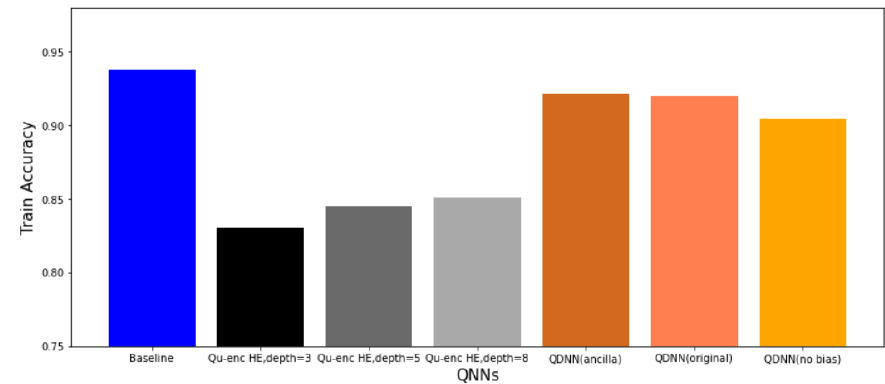
Figure 8. Accuracy values of different QNNs.